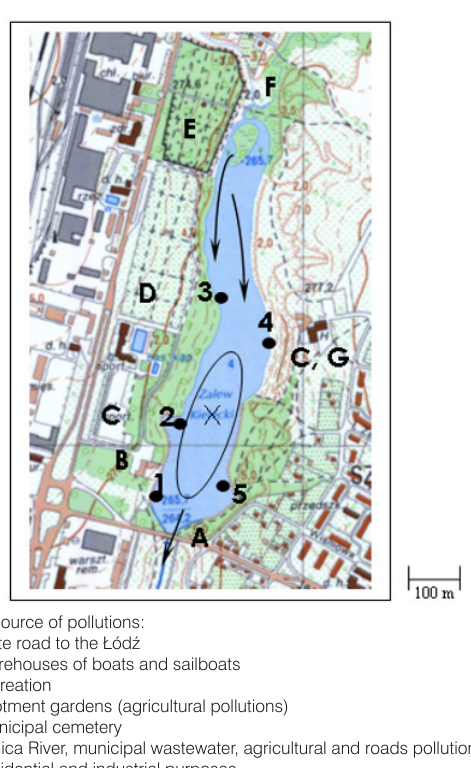
Figure 1. Bottom sediment sampling sites in the Kielce Lake (x – pulverising aerator operation area; arrows represent directions of reservoir water